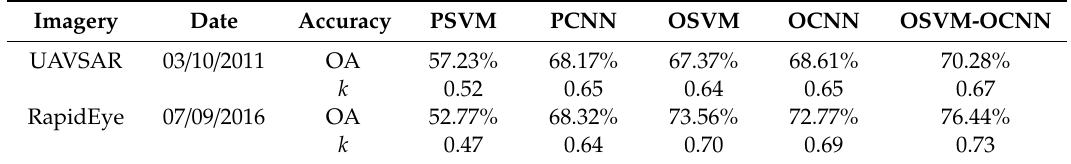
Table 6. Classification accuracy comparison amongst PSVM, PCNN, OSVM, OCNN and the proposed OSVM-OCNN method using additional UAVSAR and RapidEye